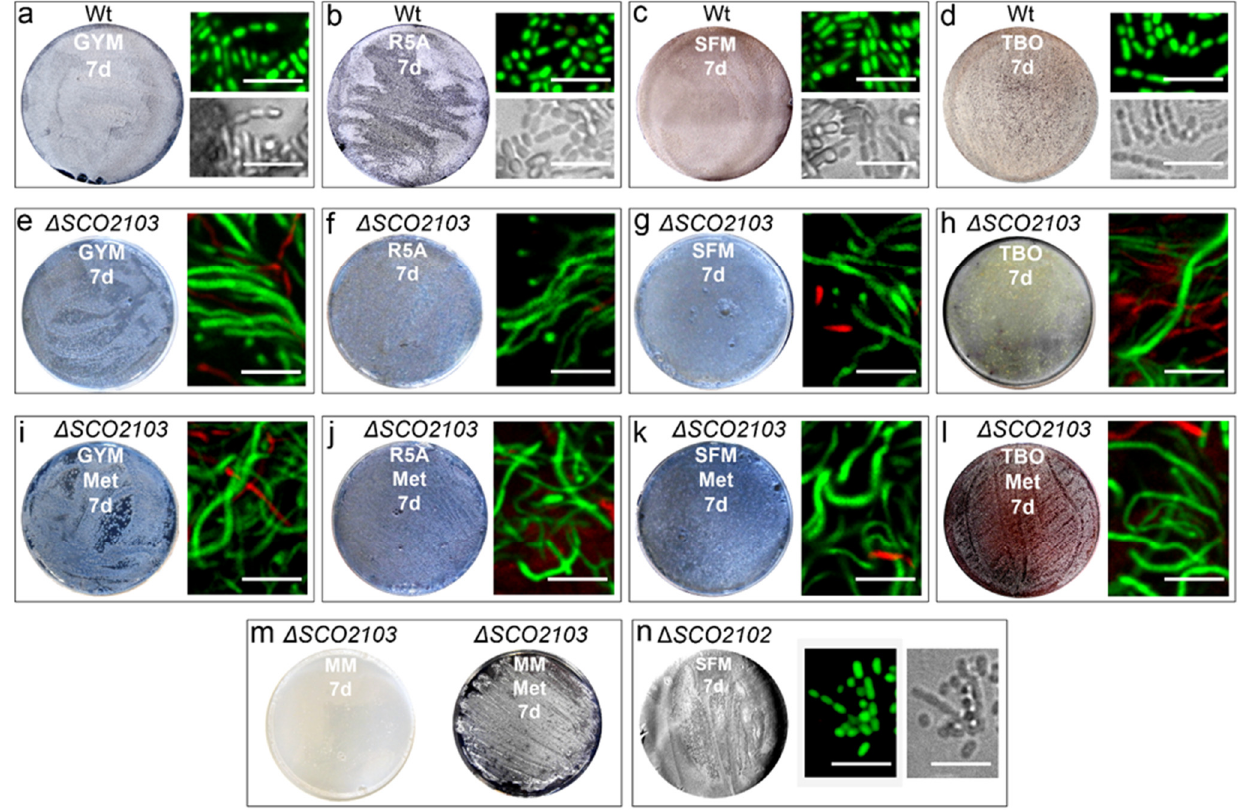
Figure 3. ∆ SCO2102/SCO2103 sporulation on solid cultures. ( a – d ) Wild-type in different culture media. ( e – h ) ∆ SCO2103 bald phenotype in different culture media. ( i – l ) ∆ SCO2103 bald phenotype in methionine-amended media. ( m ) Absence of growth of ∆ SCO2103 in minimal medium without methionine. ( n ) ∆ SCO2102 sporulation growing on SFM solid cultures. Macroscopic view of the Petri plates (grey colour indicates sporulation), laser-scanning confocal fluorescence images of hyphae stained with SYTO9 and PI and phase-contrast mode images are shown. Representative images from at least three biological replicates are shown. Scale bars indicate 5 µm.